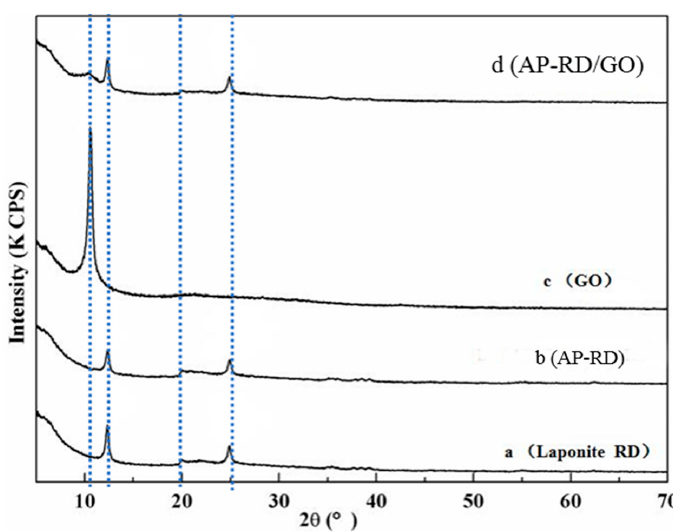
Figure 3. XRD pattern of AP–RD complex with GO. Figure 4 indicates that the absorption peak at 3693 cm − 1 and 3620 cm − 1 was derived from the stretching vibration peak of Al-OH in RD, while the absorption peak at 910 cm − 1 was attributed to the bending vibration peak of Al-OH [26,27]. In contrast to curve (a),